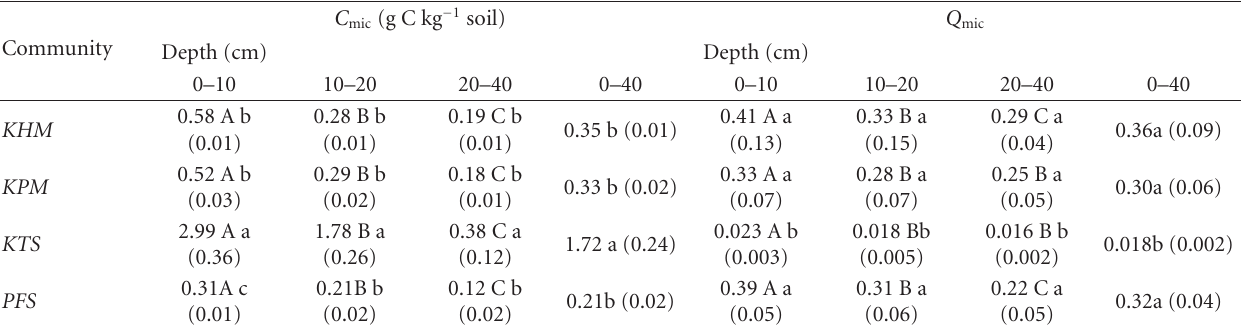
Table 2: Microbial biomass C of soil samples in four alpine meadow plant communities (Mean ± SD). Data in the table were mean values of 3 years. Numbers in parentheses indicate standard deviation ( n = 6). Data from di ff erent communities followed by the same letters were not significantly di ff erent at 0.05 levels (capital letters indicate di ff erent soil layers within the same community while small letters indicate the same soil layer in di ff erent communities; Duncan’s multiple range tests). C mic : Soil microbial biomass carbon; Q mic : Soil microbial quotient. Kobresia humilis meadow = KHM ; Kobresia pygmaea meadow = KPM ; Kobresia tibetica swamp meadow = KTS ; Potentilla fruticosa scrub = PFS